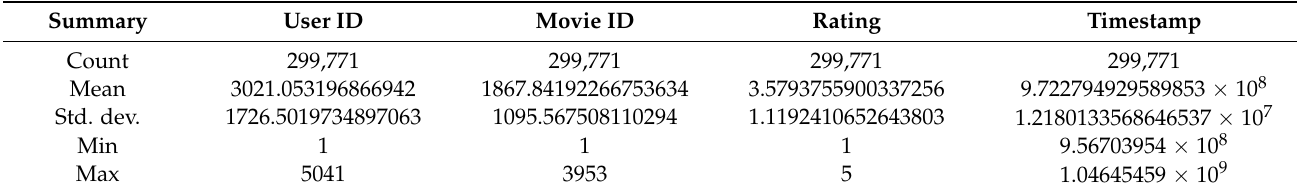
Table 1. A brief description of the Movielens dataset.